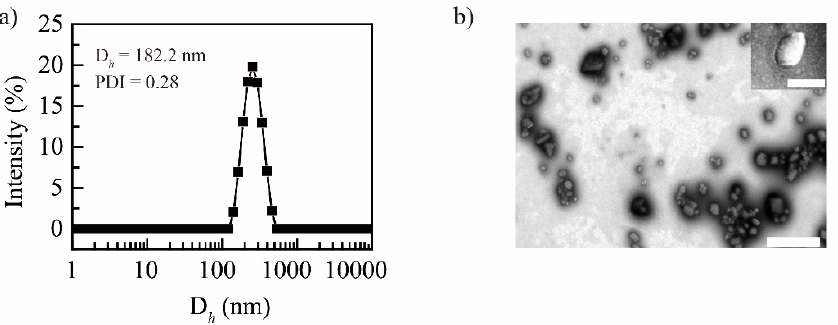
Figure 1. Particle size distribution curve ( a ) and TEM image ( b ) of NRG NPs, scale bar: 500 nm (insert, scale bar: 100 nm).